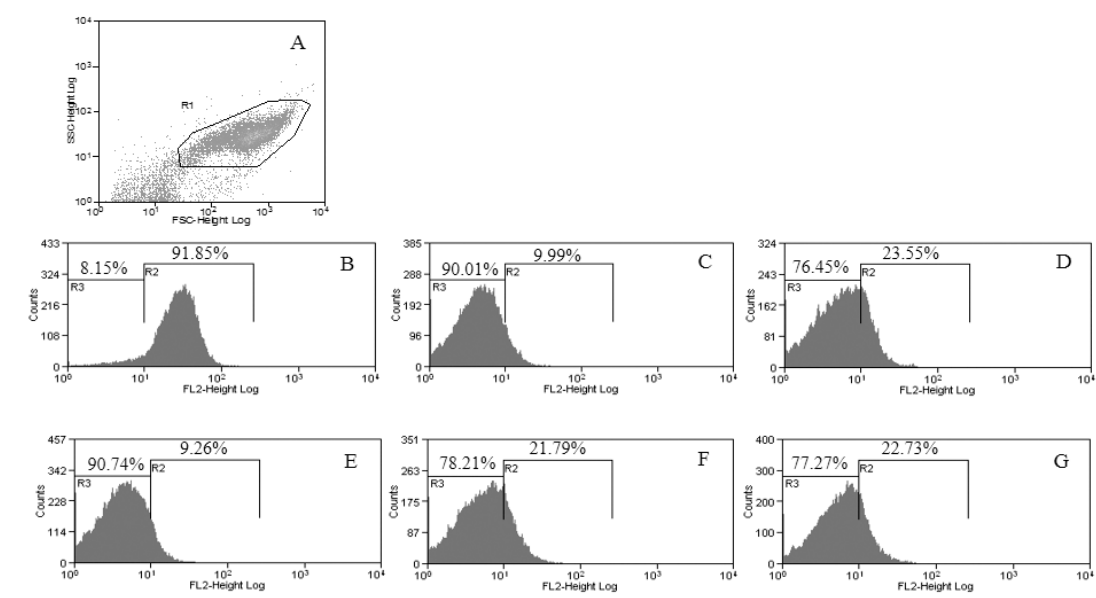
Figure 6. Flow cytometry of Leishmania amazonensis treated with 7.93 µ g / mL of Endlicheria bracteolata essential oil to evaluate the mitochondrial membrane potential ( ∆Ψ m). ( A ) Promastigotes captured in the gated region. ( B – G ) representative histograms of non-treated promastigotes incubated with TMRE showing ∆Ψ m intact in R2 and change of ∆Ψ m in R3. Promastigotes untreated ( B ) and treated for 2 h ( C ), 4 h ( D ), 8 h ( E ), 16 h ( F ), and 24 h ( G ).